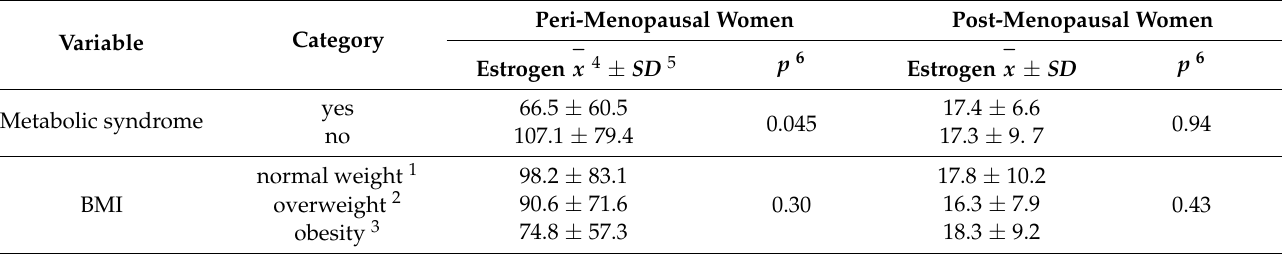
Table 4. Serum estrogen concentration (pg/mL) in peri- and post-menopausal women by prevalence of metabolic syndrome and by BMI.